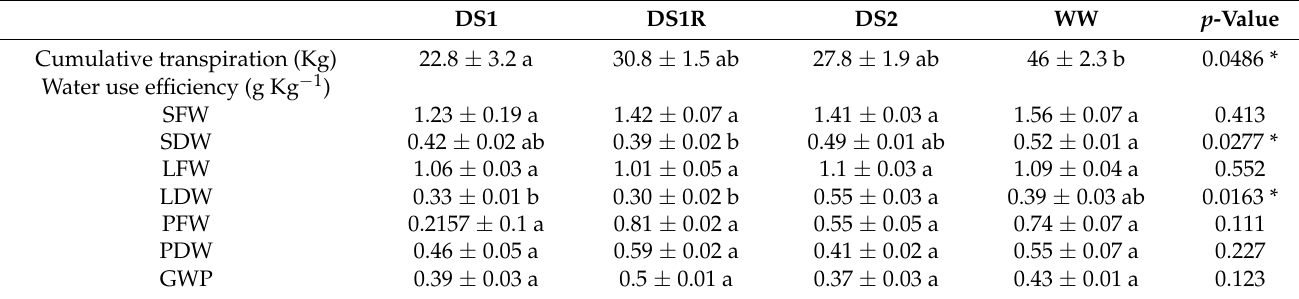
Table 4. Water use efficiency estimated for stem and leaf biomass and grain production at physiological